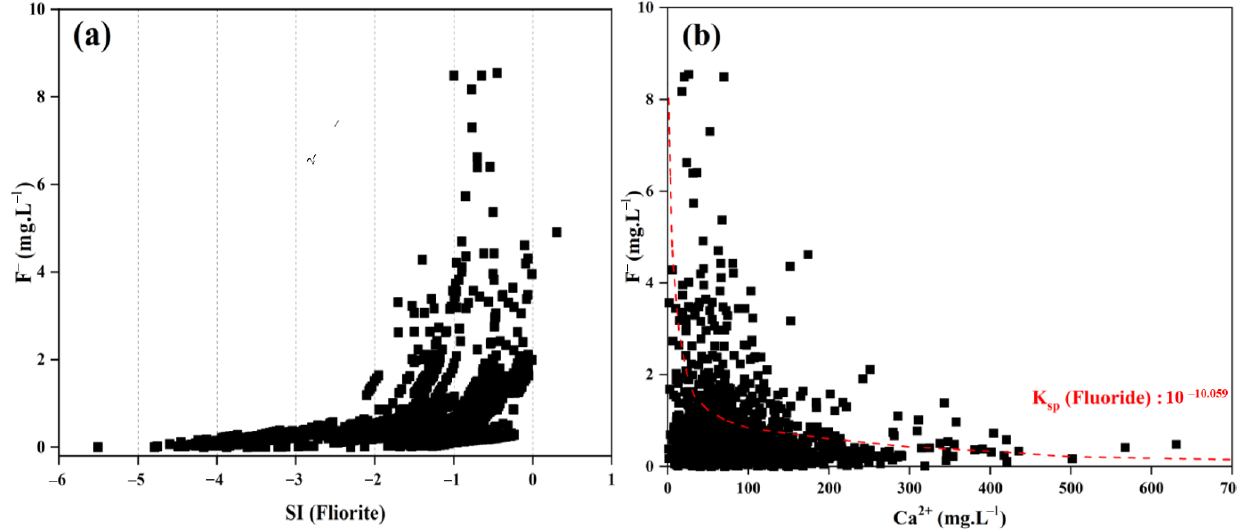
Figure 4. Relationship between F − concentration and SI(Fluorite) ( a ); Ca 2+ concentration ( b ).